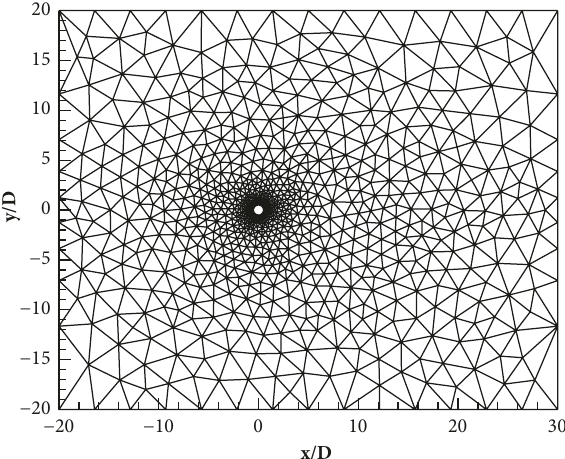
Figure 7: Computational grid for flow around a circular cylinder.